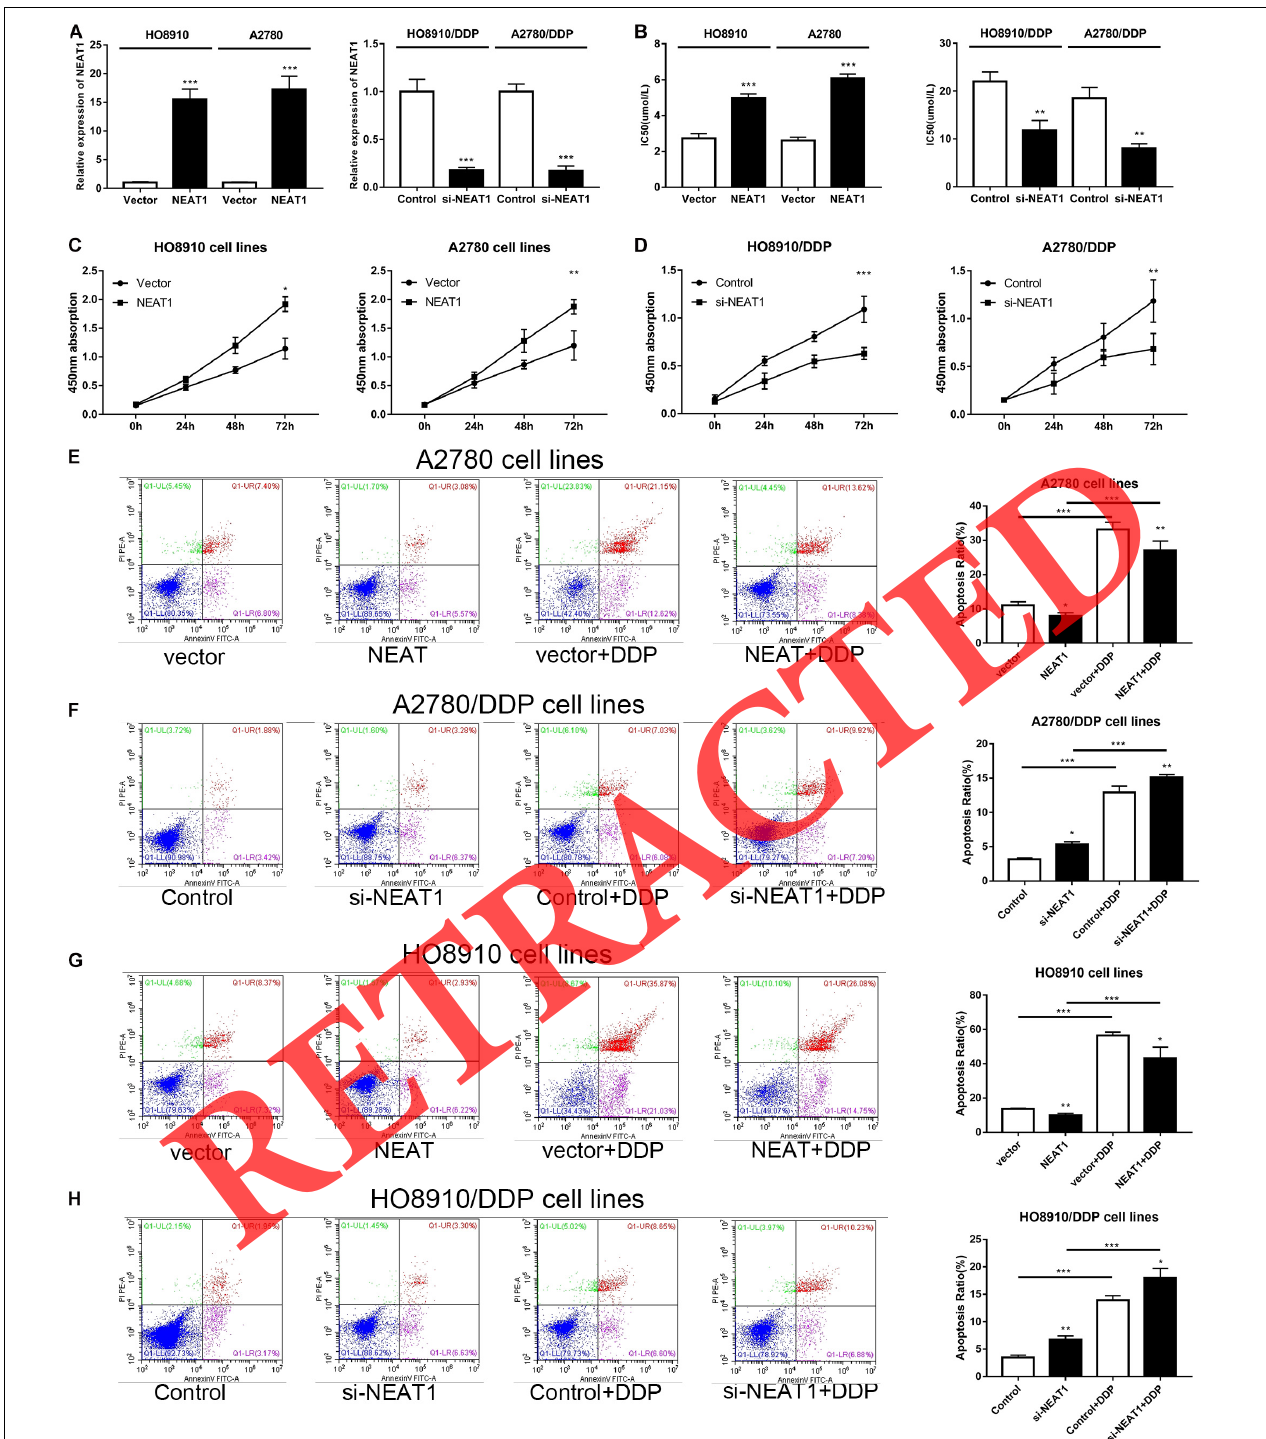
FIGURE 2 | NEAT1 affected the OC cell proliferation and apoptosis in vitro. (A) QRT-PCR analysis of NEAT1 expression in OC cells post transfection with si-NEAT1 or NEAT1 plasmid. (B) IC50 of cisplatin-resistant or cisplatin-sensitive cells with increased or decreased NEAT1 level. (C) Promotion effects of overexpressed NEAT1 on the proliferation of A2780 and HO8910 cells during CCK-8 assay. (D) Suppression of NEAT1 silencing on the proliferation of A2780/DDP and HO8910 cells with 4 mg/mL cisplatin as shown by CCK-8 assay. (E–H) Flow cytometry of apoptosis of A2780 and HO8910 cells post transfection with vector or pcDNA-NEAT1; A2780/DDP and HO8910/DDP cells post transfection si-Control or si-NEAT1 before the stimulation of 4 mg/mL cisplatin treatments. All tests were conducted for at least three times. Data were reported as mean ± SD. * p < 0.05, ** p < 0.01, *** p < 0.001.